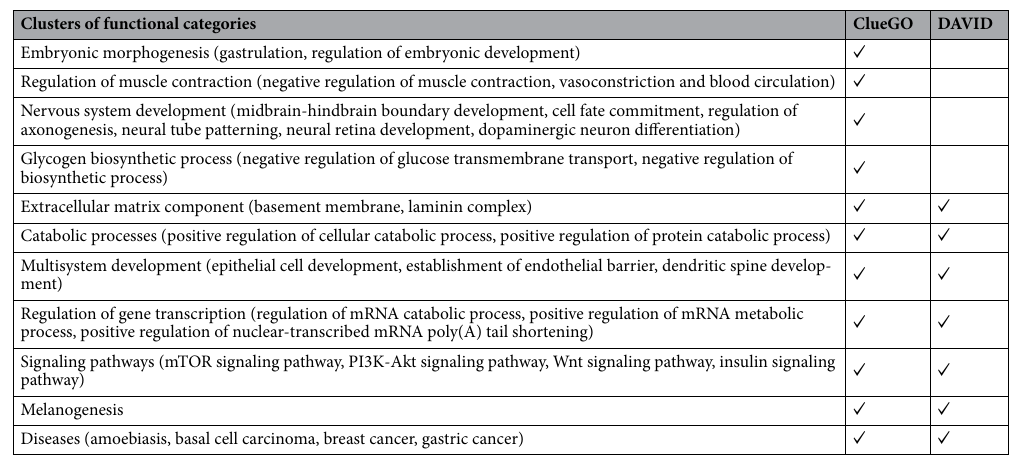
Table 3. Comparison between ClueGO and DAVID results. In this table, the clusters of functional terms identified by the ClueGO analysis are reported. The ticks show the clusters of functional categories identified as significant clusters with both methods (ClueGO and DAVID). Benjamini-adjusted P -value < 0.05 was chosen as the significance threshold.